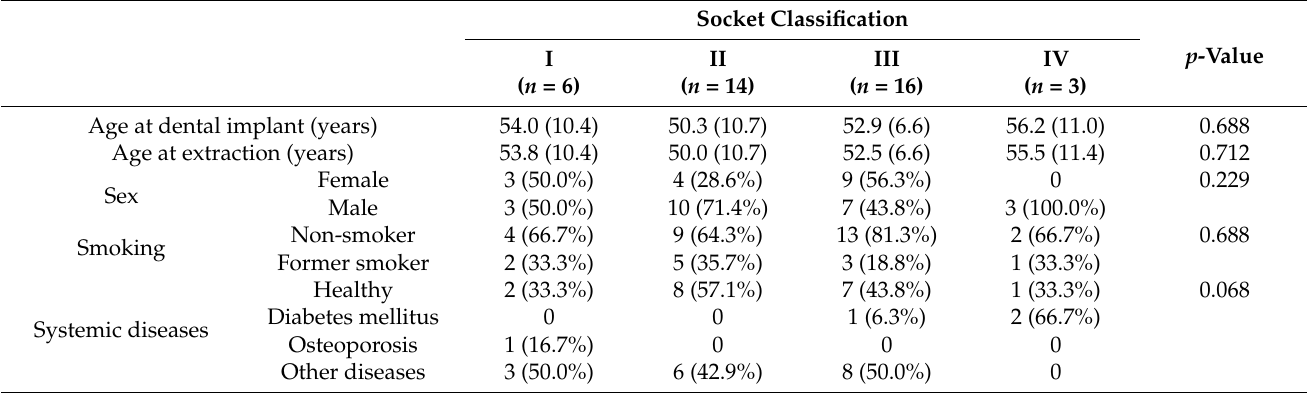
Table 3. Association of the baseline conditions and socket classification for mandibular implants with flapless ridge